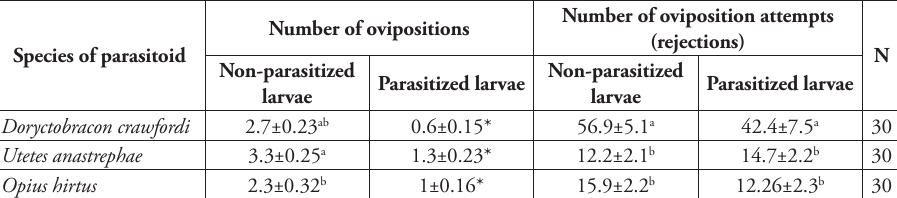
Table 2. Average values (±SE) of number of ovipositions and attempts at oviposition on host larvae para- sitized by conspecifics and non-parasitized host larvae.